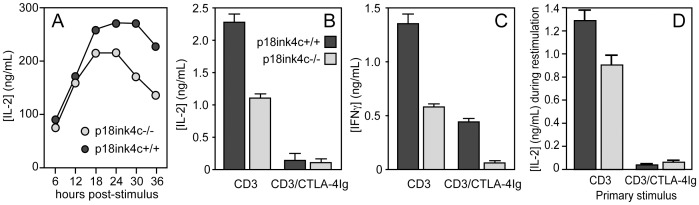
Reduced cytokine production by p18ink4c-deficient T cells.T cells from p18ink4c+/+ (dark gray symbols) or p18ink4c−/− (light gray symbols) mice were stimulated with soluble anti-CD3 Ab (5 µg/mL) or anti-CD3 plus CTLA-4Ig (10 µg/mL). IL-2 (A and B) and IFNγ (C) in the supernatants of primary cultures was measured by ELISA at the indicated time points in A, at 24 hours in B, and at 72 hours in C. CD4+ T cells purified from the primary cultures in A–C were rested, restimulated with plate-bound anti-CD3 (1 µg/mL), and IL-2 secretion was measured by ELISA at 18 hours post-stimulation (D). Data are plotted as the mean +/−SEM of duplicate cultures, and are representative of 2–3 independent experiments.